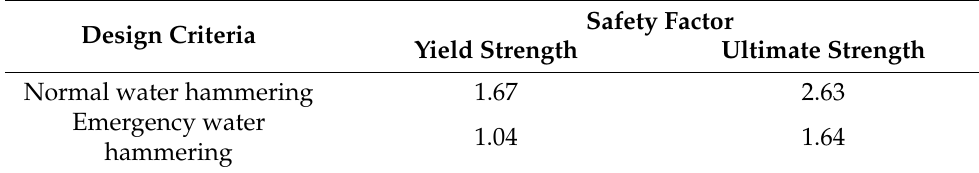
Table 3. Safety factor for limiting steel stress, as proposed by Gordon (1978).